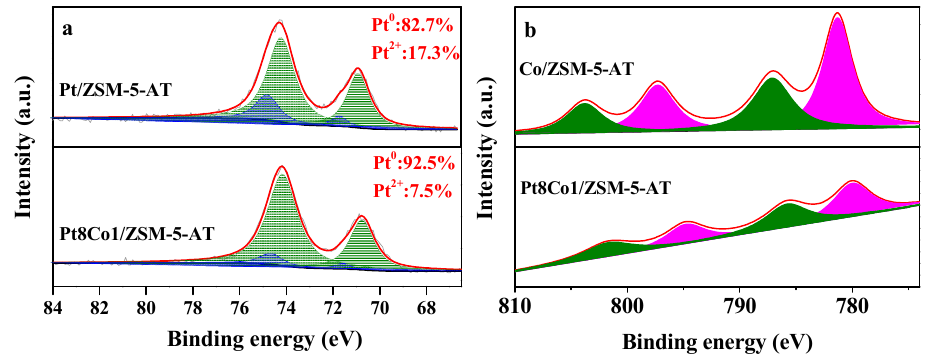
Figure 5. ( a ) Pt 4f XPS spectra of as-prepared Pt8Co1/ZSM-5-AT and Pt/ZSM-5-AT catalysts. ( b ) Co